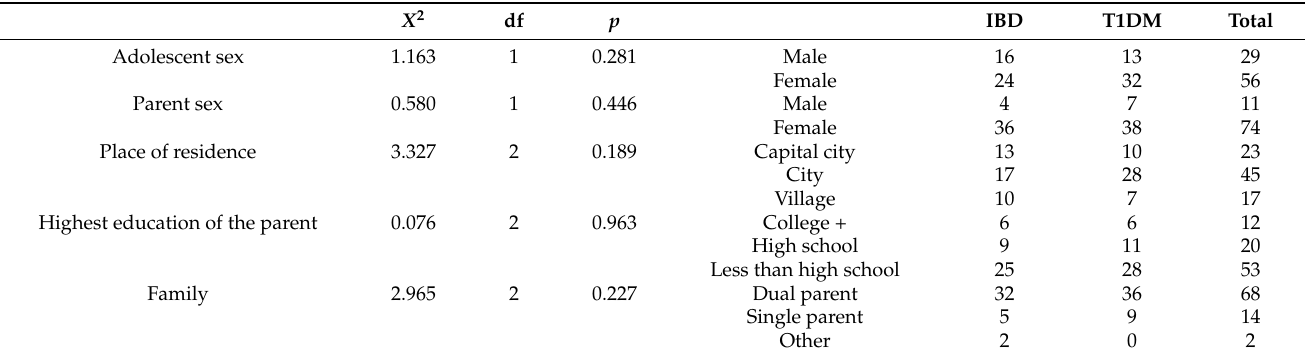
Table A3. The results of chi-square tests between the diagnosis and demographic characteristics. X 2 df p